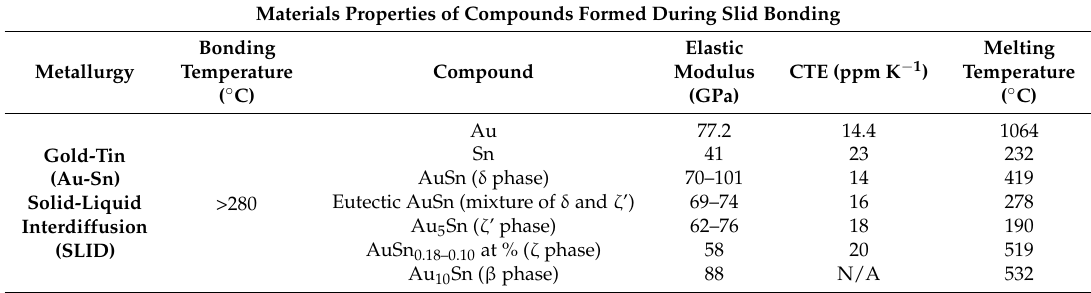
Table 6. Properties of gold-tin (Au-Sn) solid-liquid interdiffusion (SLID) bonding compounds